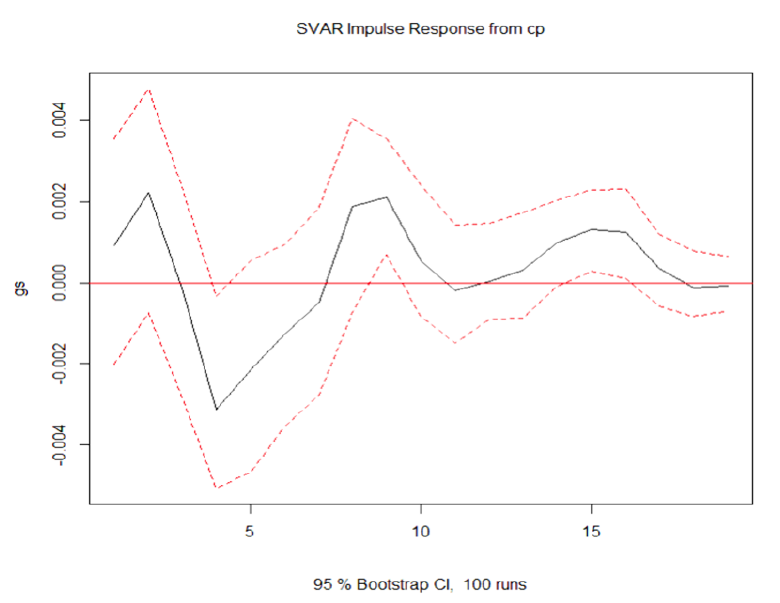
Figure 5: The SVAR Impulse Response of natural gas price from corona panic index; Source: Author’s